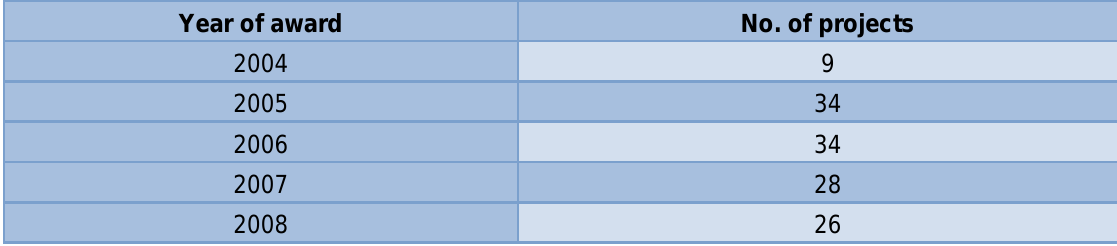
Table 2 Projects distribution based on year of award in the collected data